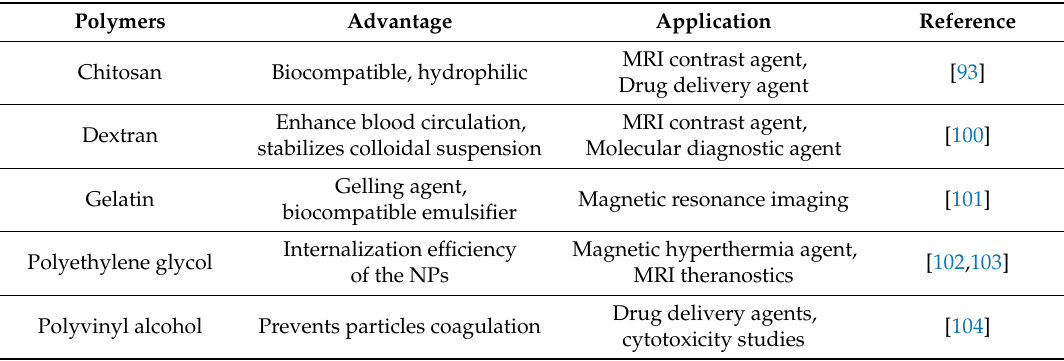
Table 5. Common polymers used for functionalized IONPs in biomedical